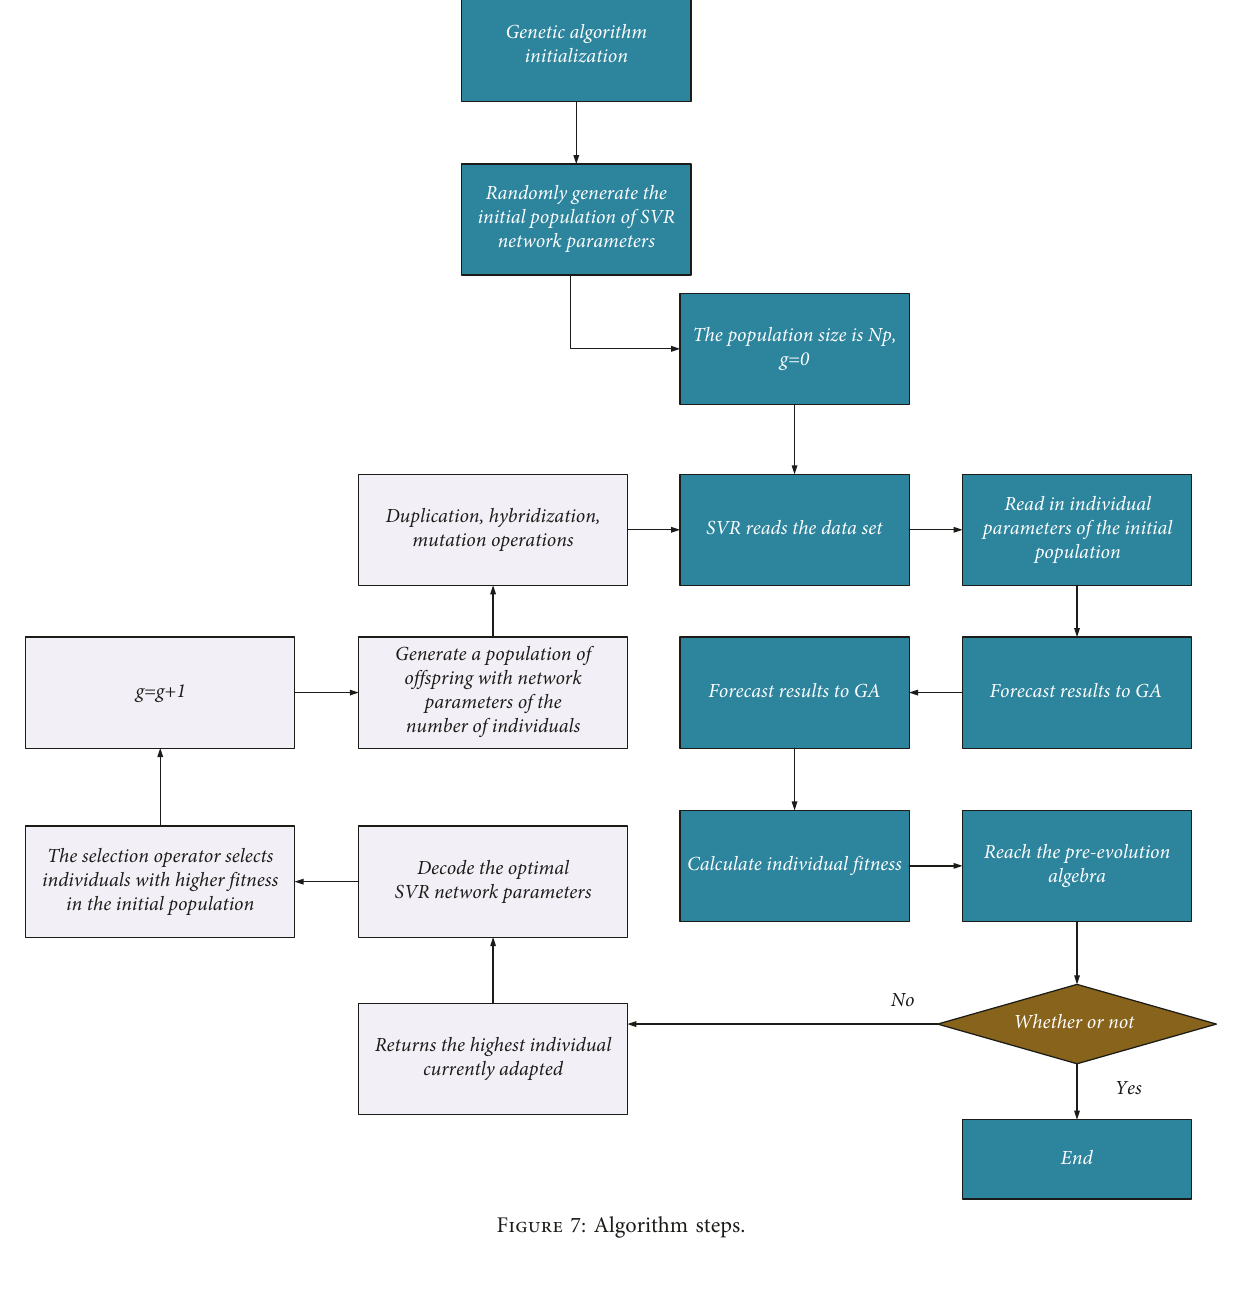
Figure 7: Algorithm